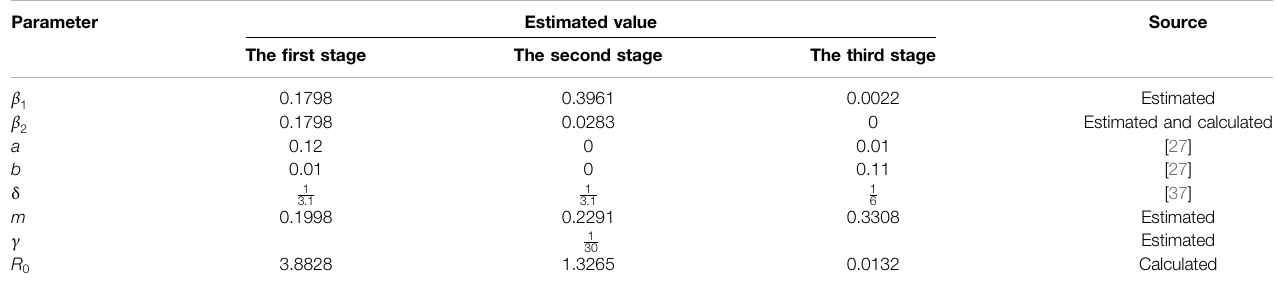
TABLE 3 | Parameter estimation of COVID-19 in Hunan